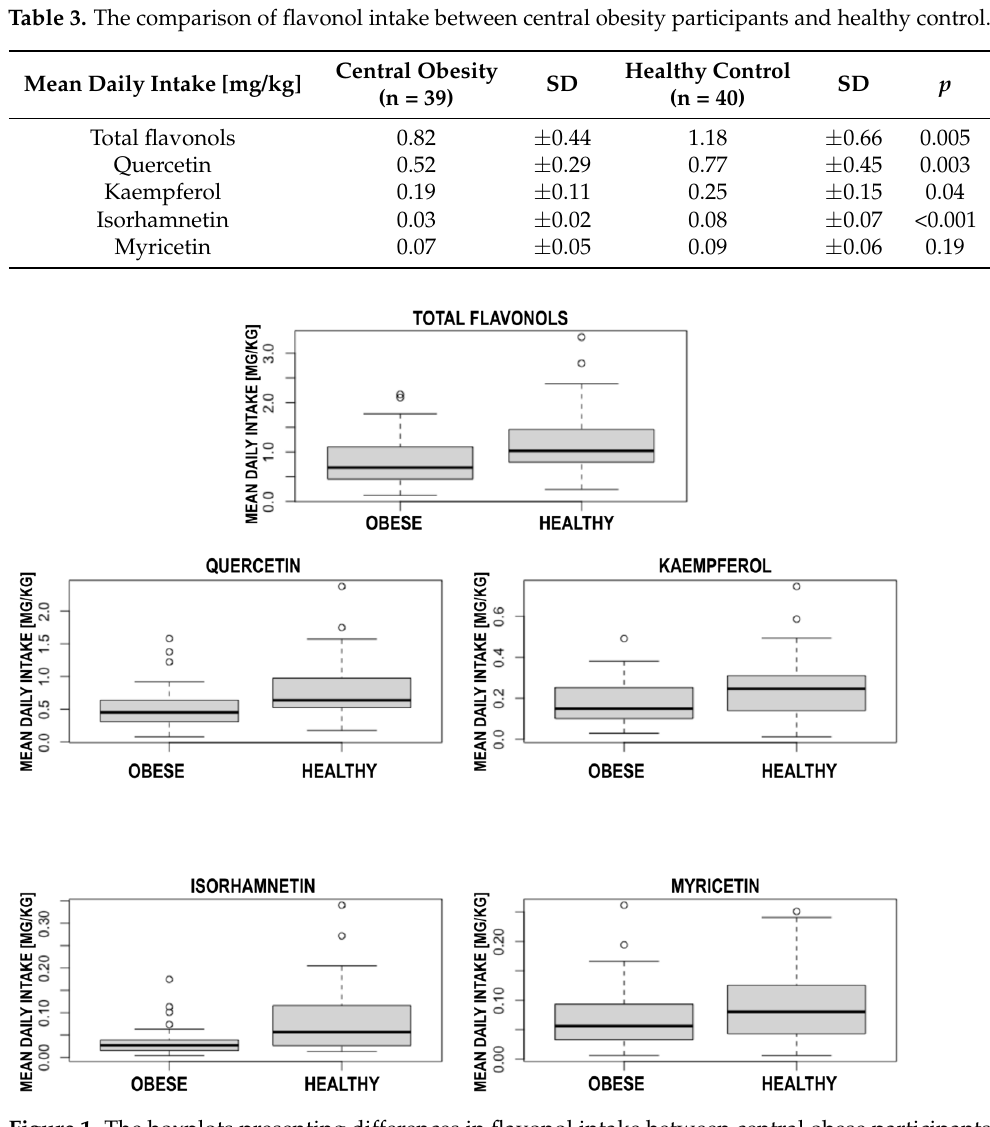
Figure 1. The boxplots presenting differences in flavonol intake between central obese participants and healthy control.